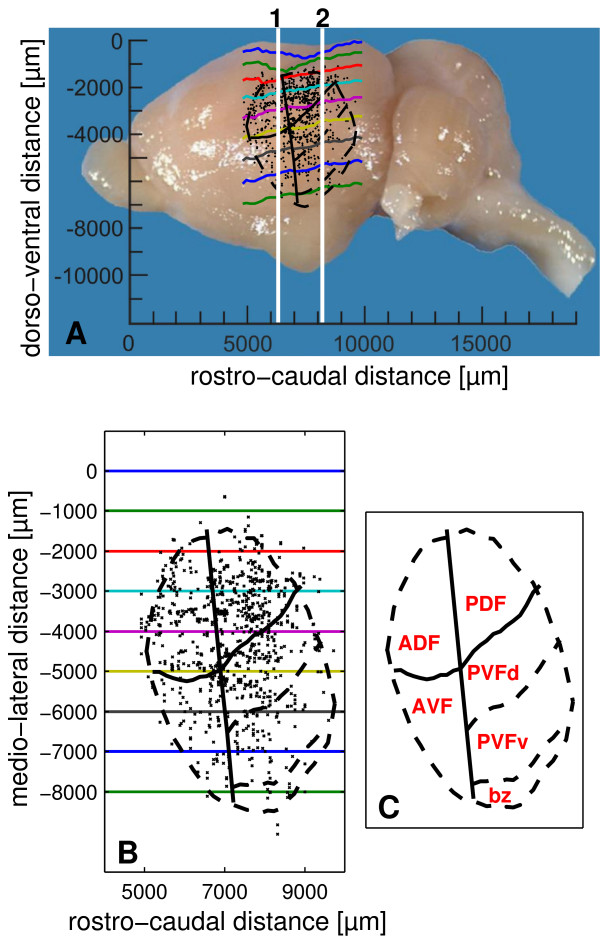
Recording sites and subfields in the auditory cortex of Phyllostomus discolor. A) Lateral view of the P. discolor brain. Recording sites of all 849 units are indicated as black dots. Superimposed black outlines are neuroanatomically determined borders. Solid black lines represent reliable borders, whereas stippled black lines represent more variable borders. Rostro-caudal positions of frontal sections shown in Fig. 2 are indicated by the white vertical lines. Colored lines represent equal medio-lateral distances from the midline in 1000 μm steps as shown in the flattened cortical surface projection in 1B. B) Projection of recording sites (black crosses) and neuroanatomical borders (black lines) on an unrolled and flattened cortical surface. Lateral distances on the cortical surface are indicated in 1000 μm steps by corresponding colors as in the side view (1A). The origin used for the flattening process was fixed at 2000 μm lateral from the midline of the brain (upper dark blue line). C) Schematic of the auditory cortical subfields: anterior dorsal field (ADF), posterior dorsal field (PDF), anterior ventral field (AVF) and posterior ventral field (PVF) with dorsal (PVFd), ventral (PVFv) parts and a border zone (bz) reconstructed on the flattened cortical surface. The neuroanatomically determined borders are indicated by black lines.